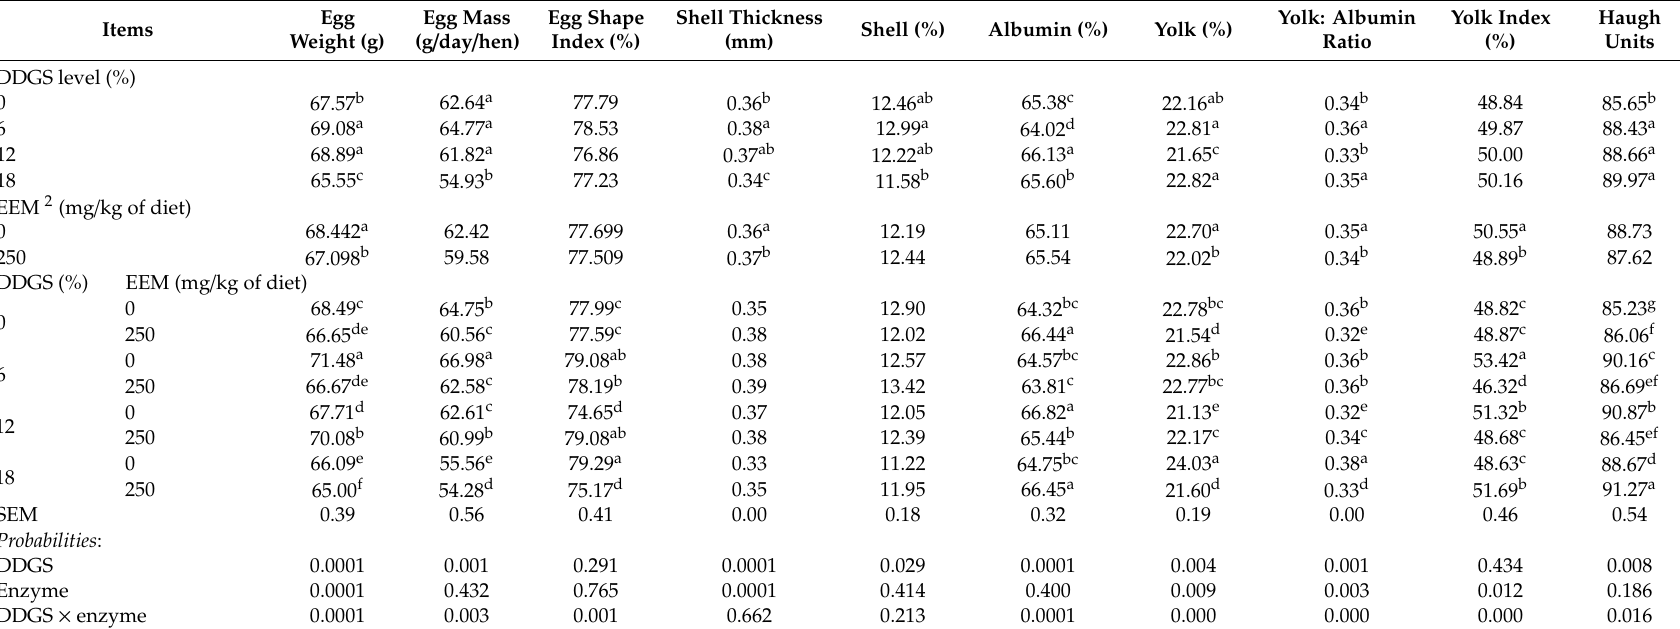
Table 3. Egg characteristics of laying hens organized by DDGS 1 inclusion levels and enzyme supplementation through 32–42 weeks of